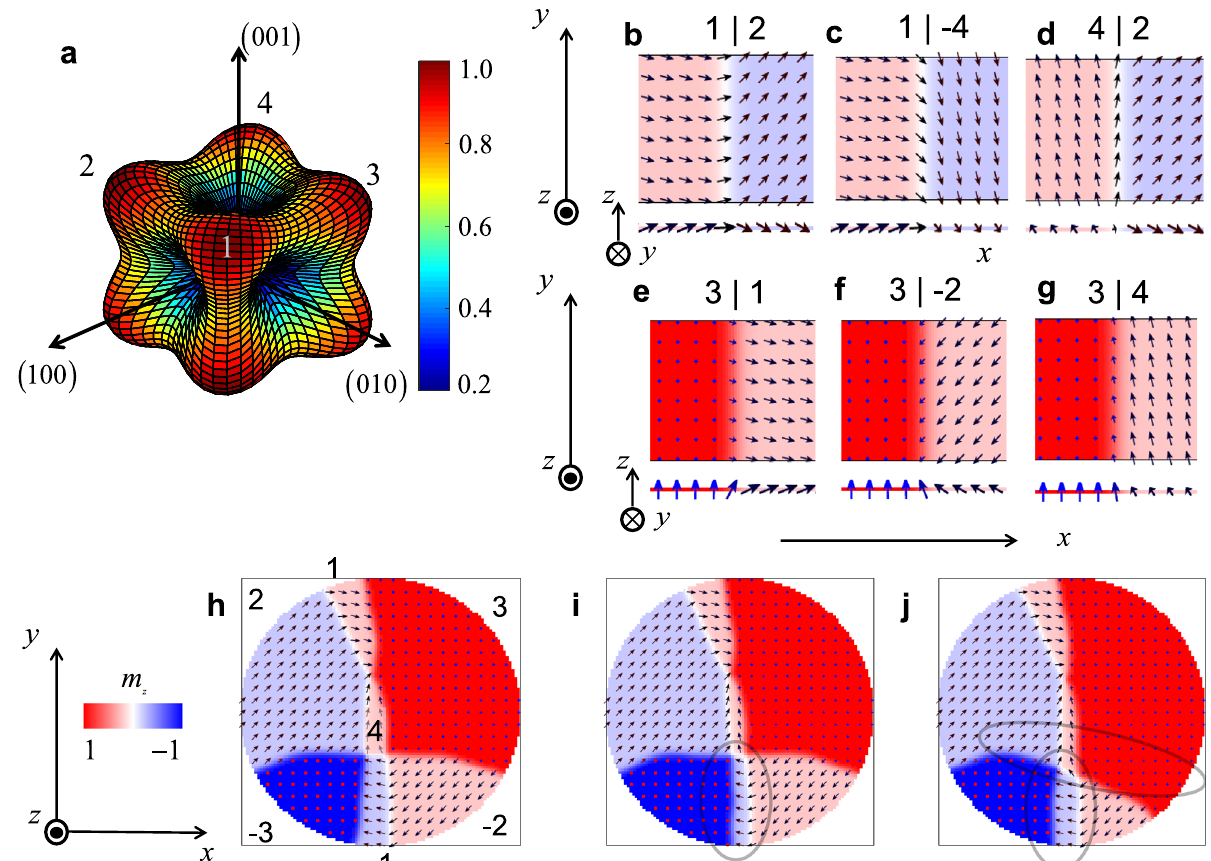
Fig. 5 Cubic anisotropy and domains projected to the laboratory reference system. a Cubic anisotropy energy density (with numbered red colors indicating more stable directions). The coordinate system refers to the crystallographic directions. b – g Snapshots of the fi rst sublattice magnetization depicting the six possible domain walls in the laboratory reference system x (horizontal arm in the real device), y (vertical arm in the real device), and z (out-of-plane direction). The snapshots correspond to the out-of-plane direction ( + z ) and an in-plane view ( − y ), as indicated by the arrows. h Multidomain state in a 500 nm diameter pillar relaxed from an initial random state. i The multidomain state after the application of a current pulse along the horizontal arm with an amplitude of 50 MA/cm 2 and width of 0.15 ns. j Multidomain state after the application of a current pulse with the same characteristics but opposite polarization.